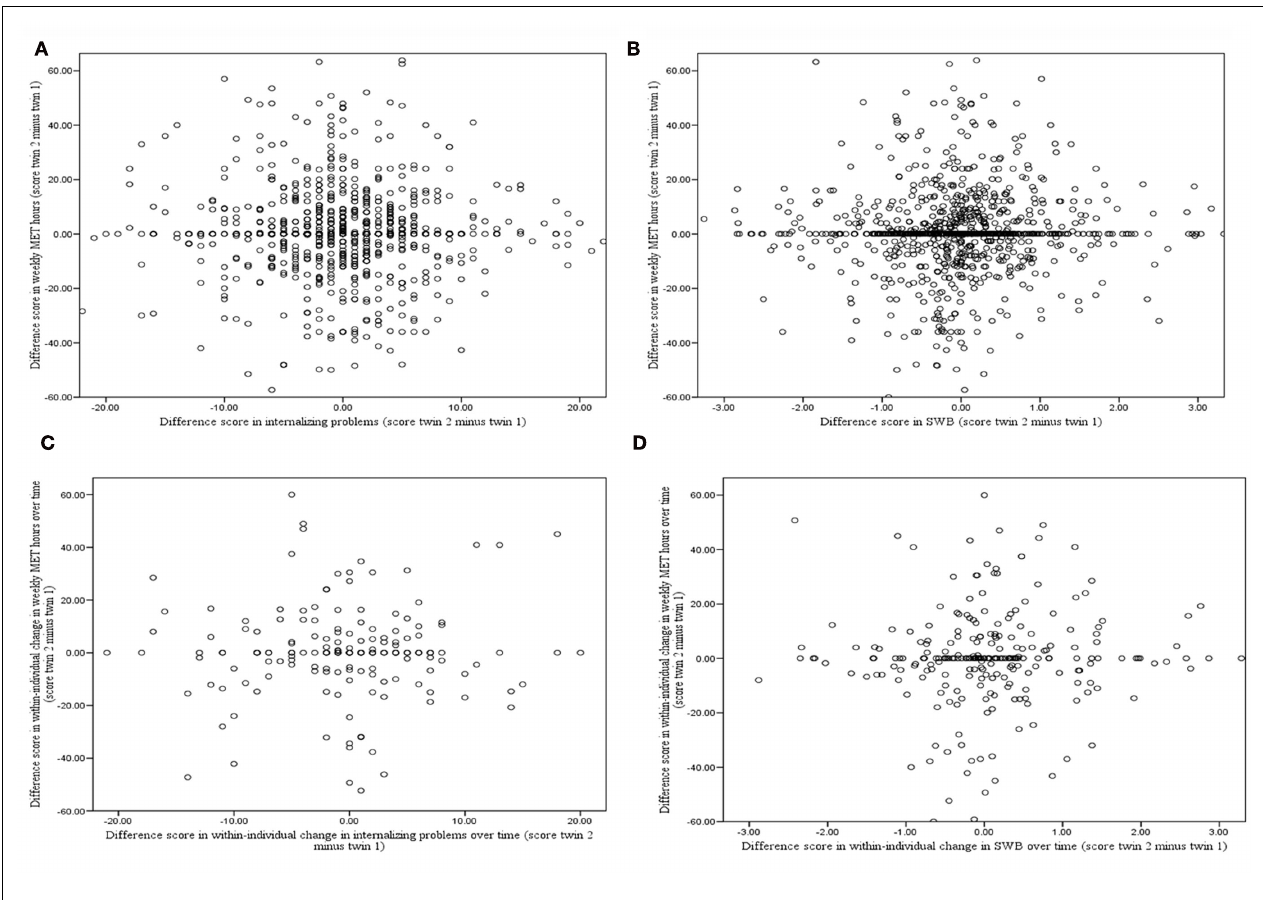
FIGURE 2 | Cross-sectional and longitudinal associations between MZ within-twin pair differences in exercise behavior and MZ within-twin pair differences in internalizing problems and SWB. (A) Corresponding standardized regression coefficient β =− 0.03 [ χ 2 (1) = 1.21, p = 0.27] for cross-sectional association between MZ within-twin pair difference in exercise behavior and internalizing problems. (B) β =− 0.01 [ χ 2 (1) = 0.03,